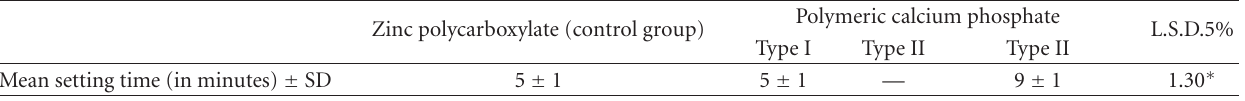
Table 2: The initial setting time (in minutes) of zinc polycarboxylate cement and the three polymeric calcium phosphate cements (CPCs).